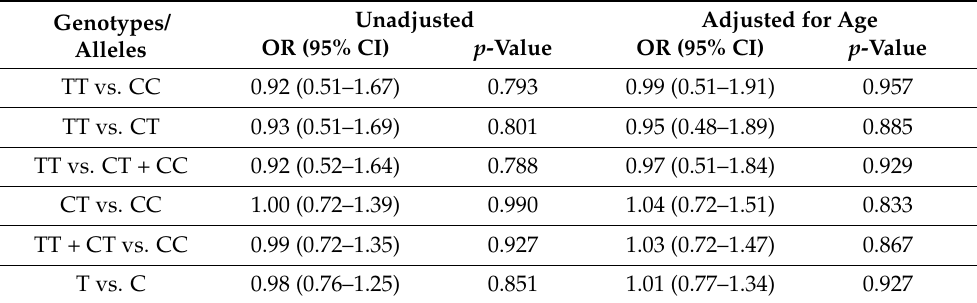
Table 1. Association of TERT rs10069690 genotypes and alleles with breast cancer risk. Genotypes/ Alleles